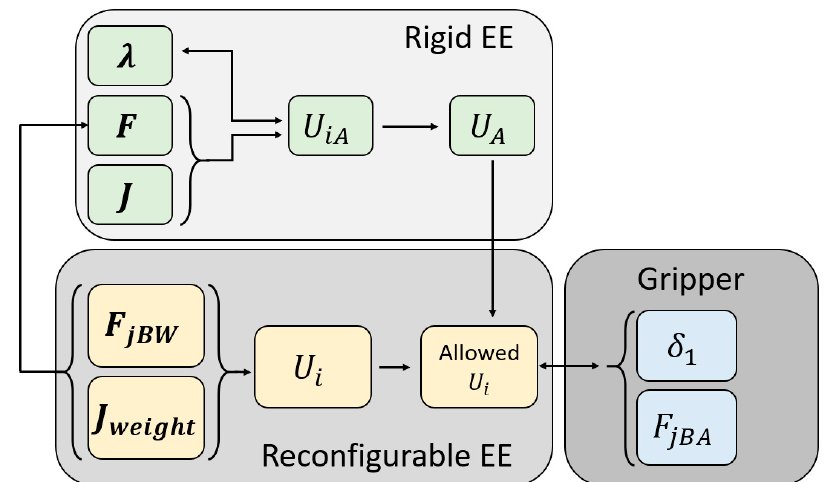
Figure 2. Scheme of the proposed methodology for obtaining the aperture and force exerted by the gripper of the reconfigurable end-effector by considering the boundaries imposed by the rigid end-effector model.